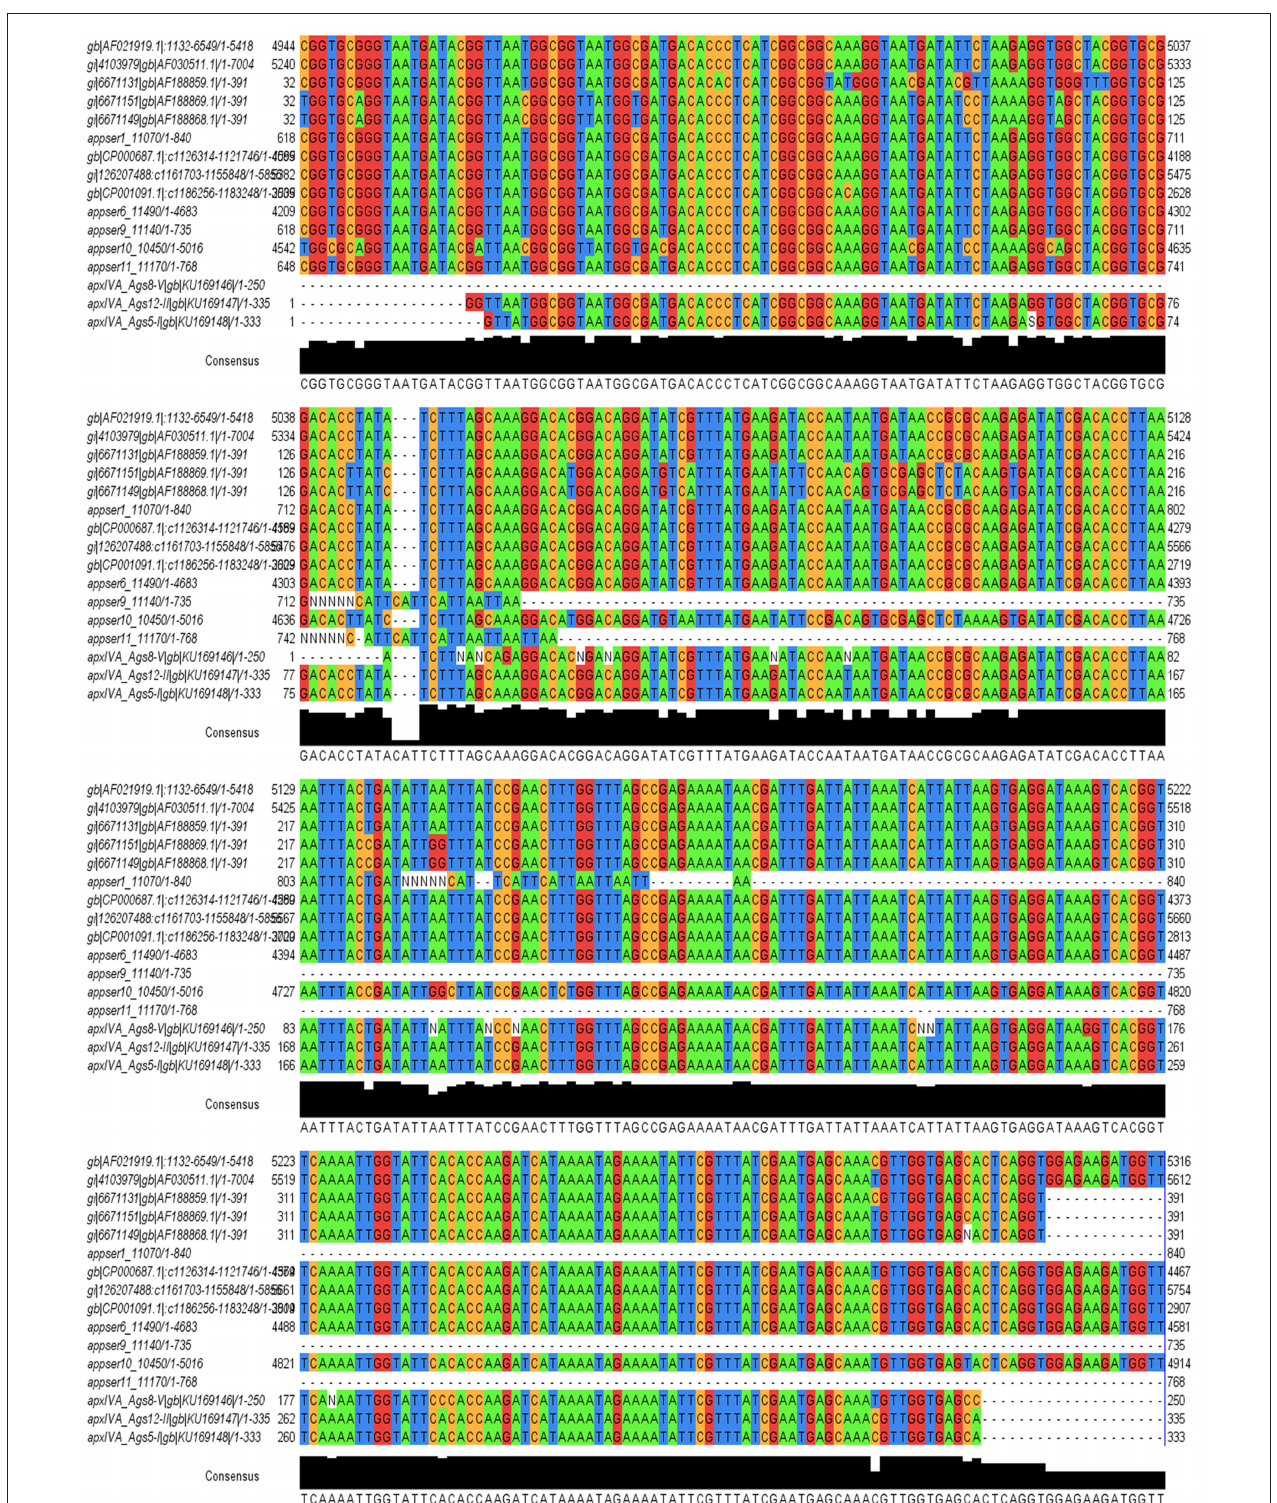
FIGURE 1 | Alignment of sequences with the program Jalview 2.9 of A. pleuropneumoniae specific gene apxIV obtained from samples of drinking water from pig farms. Samples randomly selected and positive for alignment with the sequences deposited in GenBank of apxIV gene are ApxIVA_Ags5-I (ApxIVA_Ags5-I/gb/KU169148/1-333), ApxIVA_Ags8-V (ApxIVA_Ags8-V/gb/KU169146/1-250), and ApxIVA_Ags12-II (ApxIVA_Ags12-II/gb/KU169147/1-335).